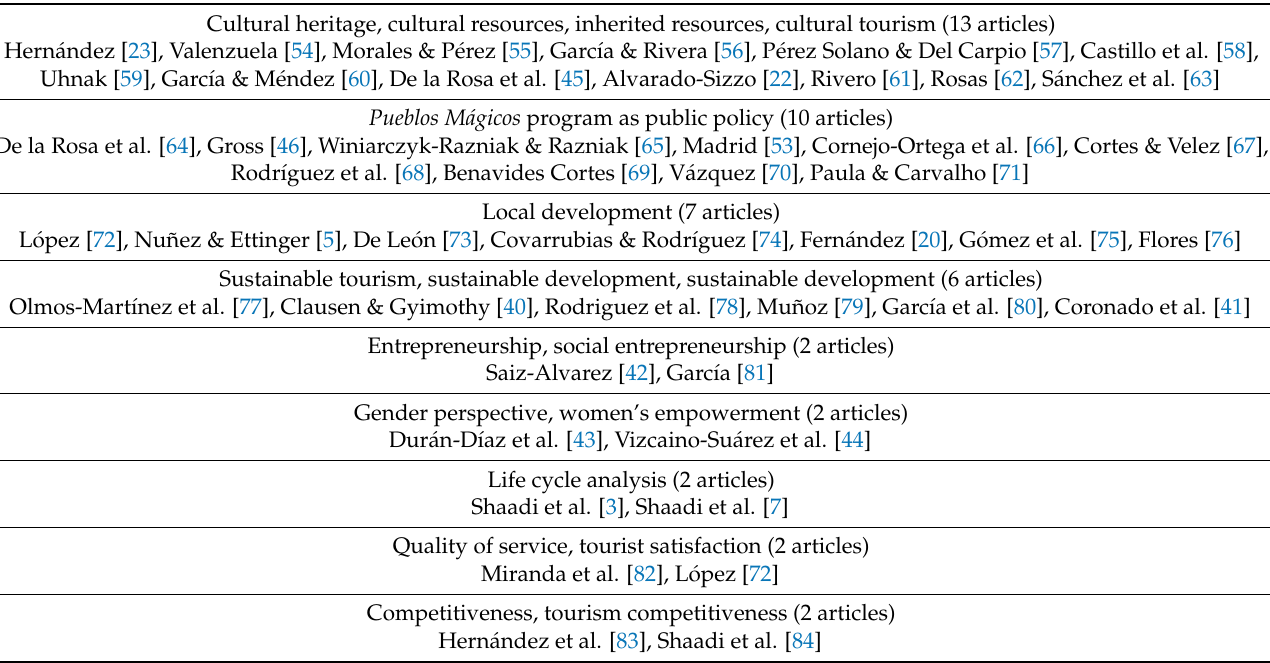
Table 11. Lines of